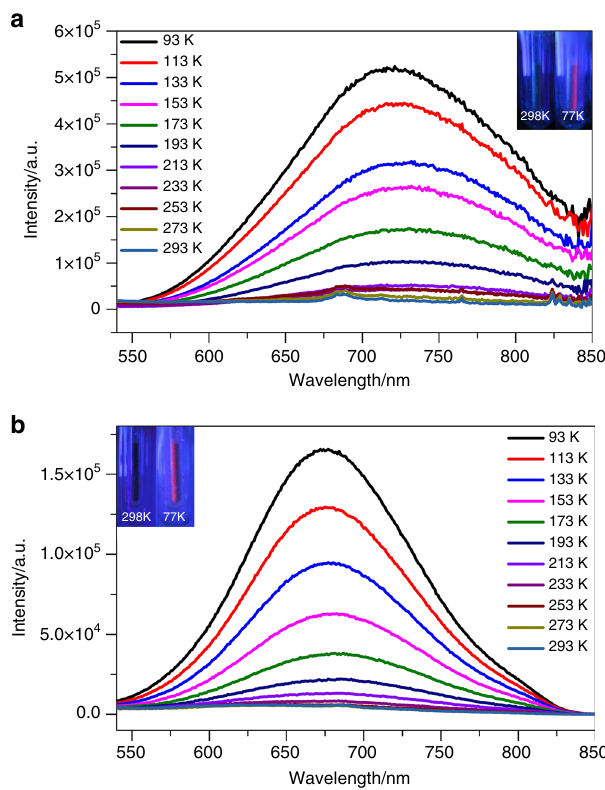
Fig. 7 Luminescence properties of SD/Ag44 and SD/Ag50 . Varied- temperature emission spectra of SD/Ag44 ( a ) and SD/Ag50 ( b ) in solid state under the excitation of 463 nm, Insets: the photographs of SD/Ag44 and SD/Ag50 irradiated by hand-held UV light ( λ ex = 365 nm) at 298